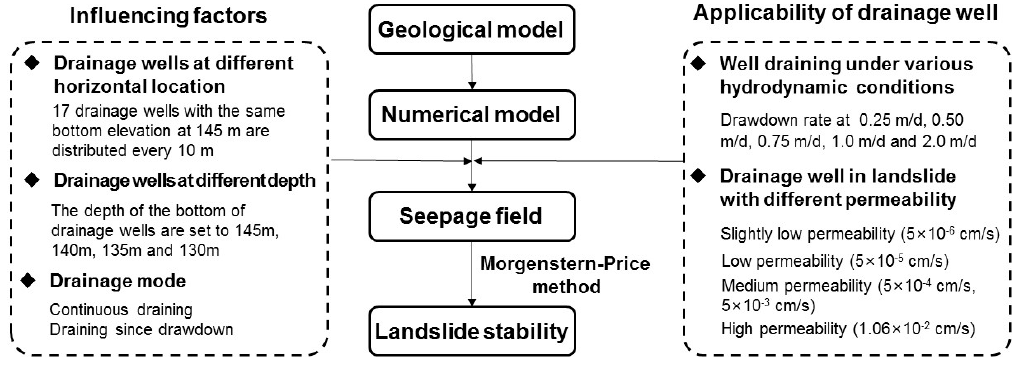
Figure 6. Framework of well drainage analysis.